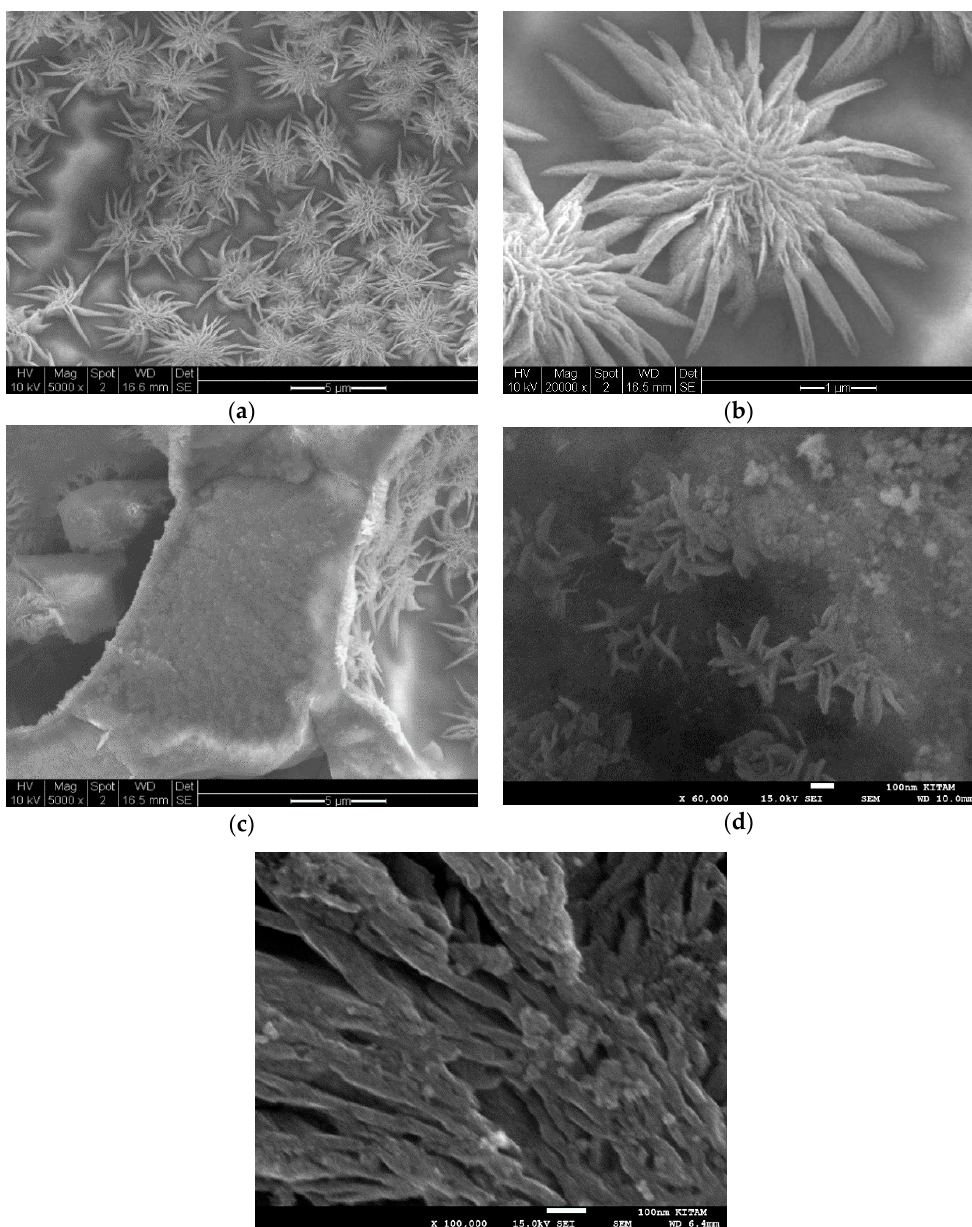
Figure 28. Structure of Co/Cu/Si = 1/1/8 Mw ‐ A binary catalyst system showing the presence of planar aggregates formed at the catalyst/air interface during the microwave irradiation (1 kW) of supported binary catalyst precursor fluid. ( a ) Wall surface structure (Scale bar = 5 μ m); ( b ) Wall surface structure at higher magnification (Scale bar = 1 μ m); ( c ) Wall cross ‐ section structure (Scale bar = 5 μ m); ( d ) Enlarged view of the wall cross ‐ section structure showing the presence of phase separation in the form of proto ‐ flower structures (Scale bar = 100 nm); ( e ) Long ribbons of supported catalyst formed from the films/elongated bubbles during boiling of the precursor fluid. These strips are several hundreds of nanometers long and ca. 40 nm wide form a porous wall structure of the catalyst (Scale bar = 100 nm).